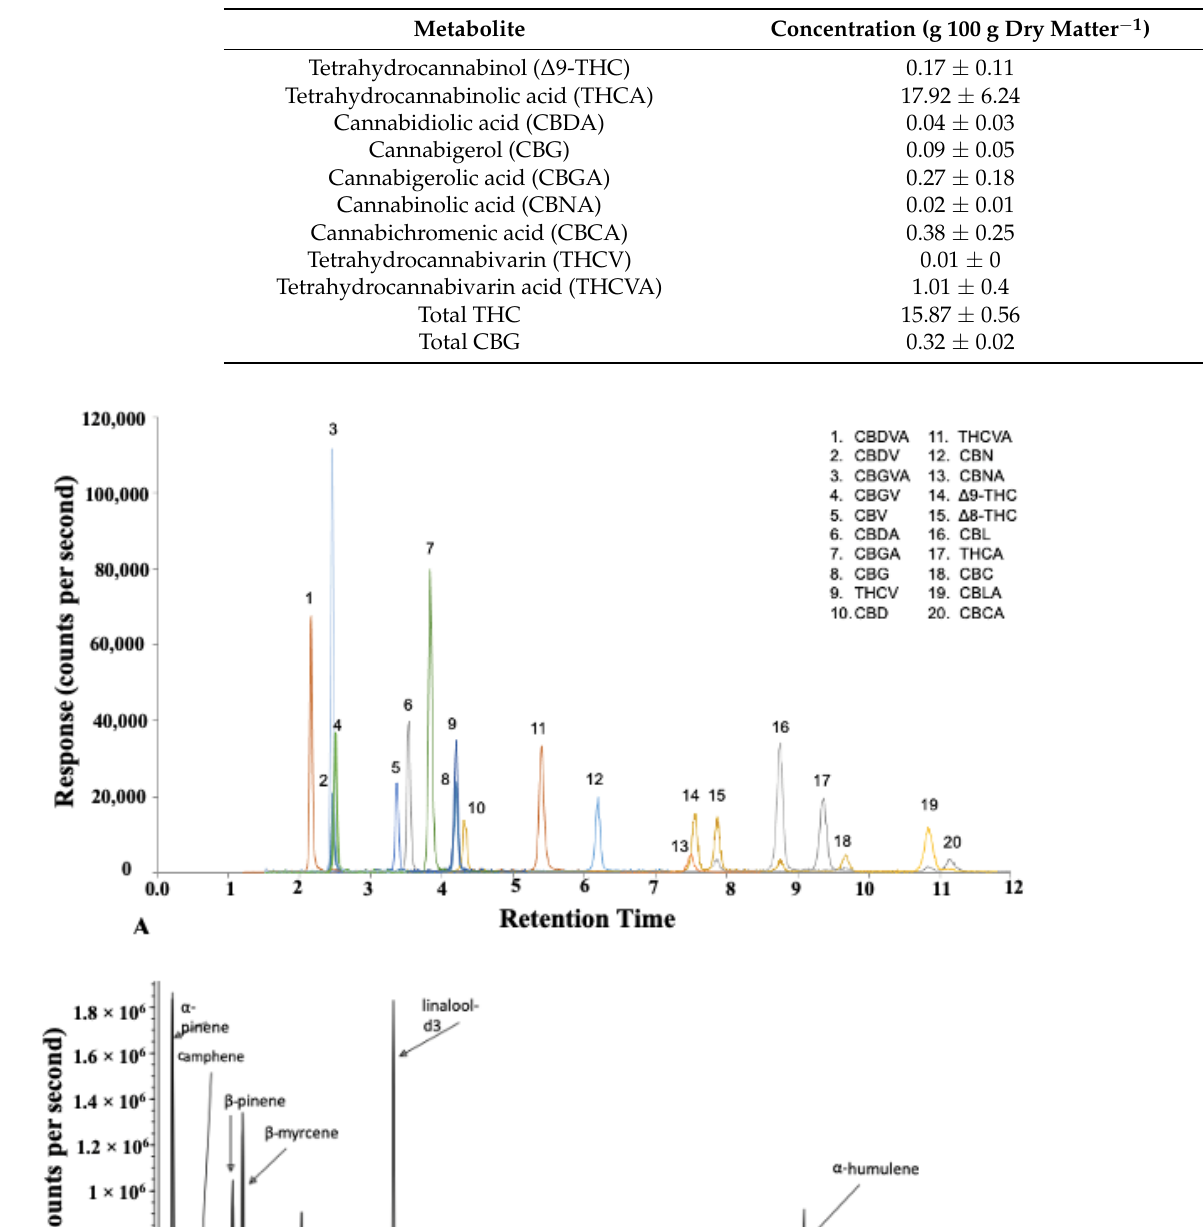
Table 1. Major cannabinoid and terpene concentrations (g 100 g dry matter − 1 ) present in cryo-ground sample.